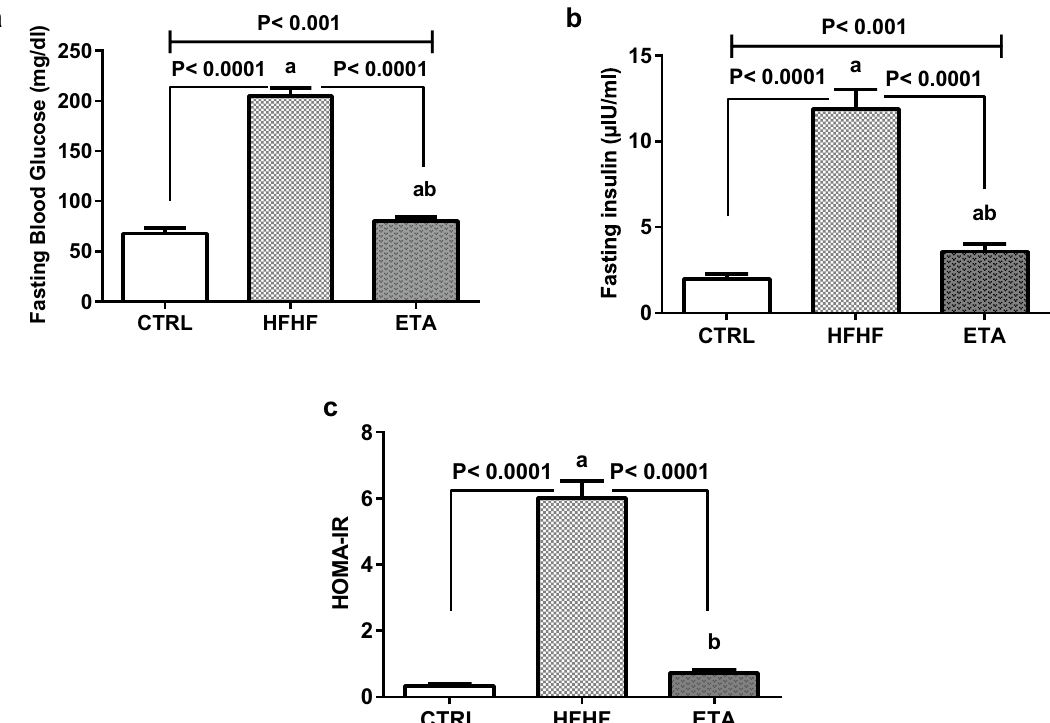
Figure 4. ETA ameliorates HFHF-induced IR. Comparison data from the HFHF-fed rats and standard chow- fed rats (CTRL) are shown: ( a ) fasting blood glucose level, ( b ) serum fasting insulin level, and ( c ) HOMA-IR. Data are presented as the mean ± SD values and are representative of a single independent experiment ( n = 6). Statistical analysis was performed using one-way ANOVA, followed by Tukey’s multiple comparison tests. a Significantly different from the normal control group. b Significantly different from the HFHF group. Differences were considered significant if the p-value was < 0.05. CTRL control, ETA etanercept, HFHF high-fat high- fructose diet, HOMA‑IR hemostatic model assessment of insulin resistance, IR insulin resistance.